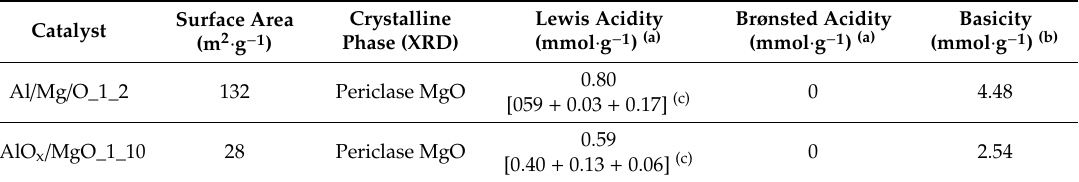
Table 2. Physicochemical properties (specific surface area, crystalline phase, Lewis acidity, Brønsted acidity and basicity) of di ff erent Al-containing MgO samples.